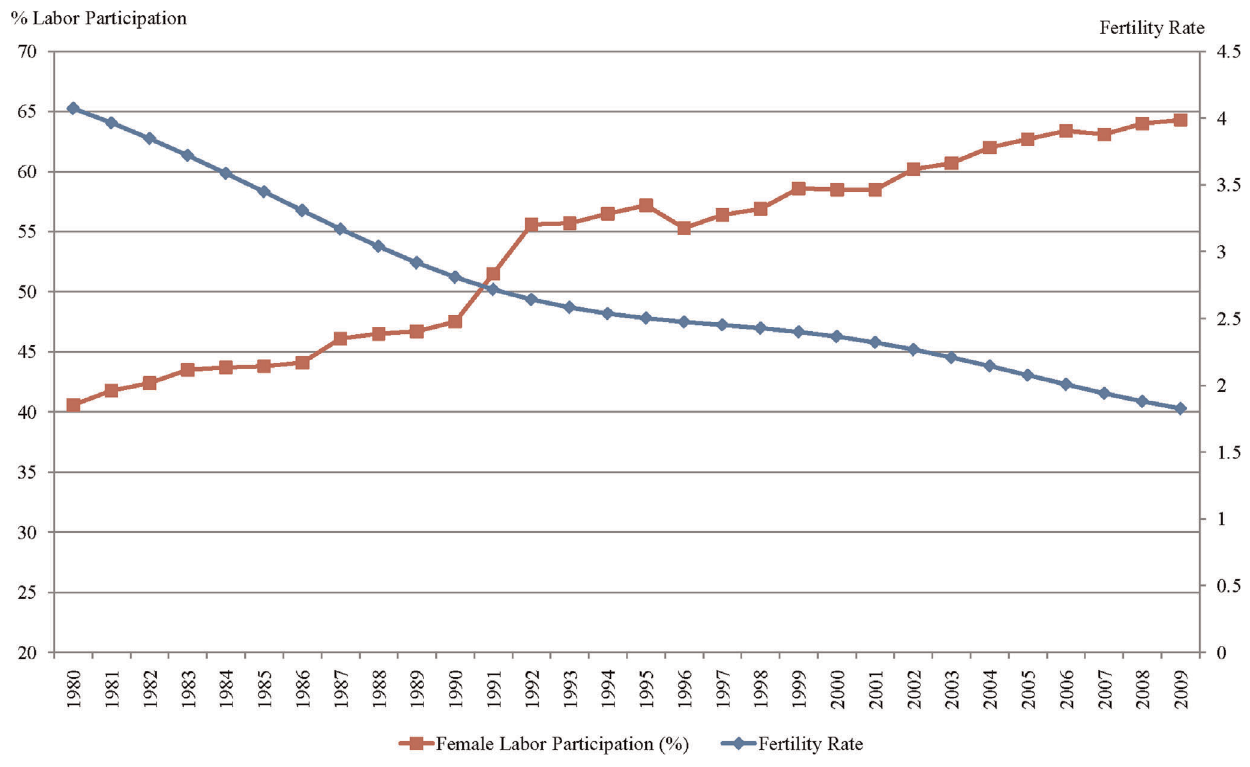
Figure 1. Fertility Rate and Female Labor Force Participation in Brazil (1980–2009). Source: World Bank.